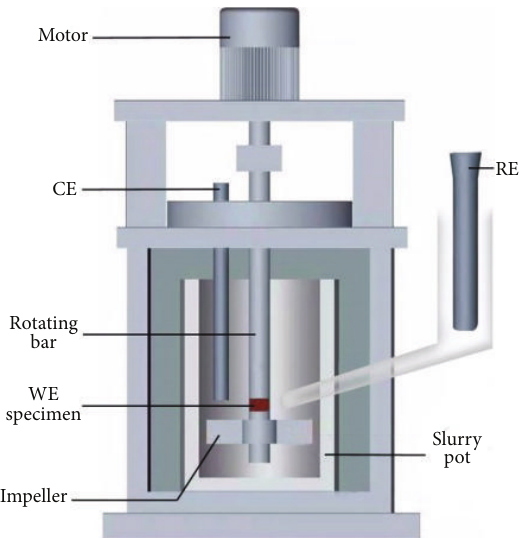
Figure 2: Schematic diagram of the modified erosion-corrosion apparatus.